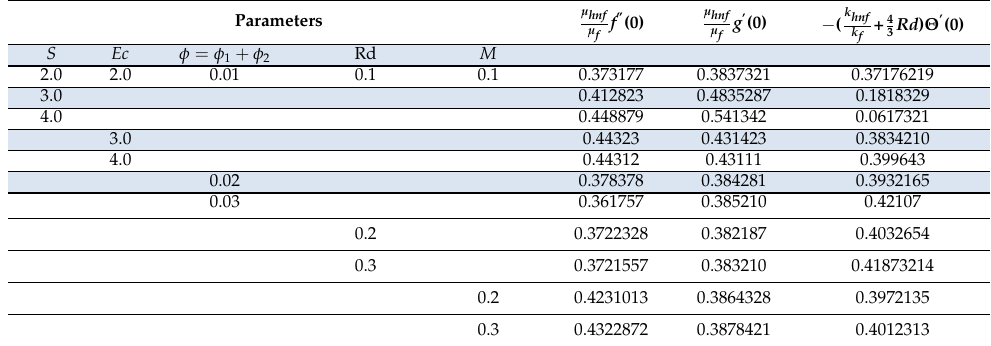
Table 4. The statistical outcomes for Nusselt number and skin friction.